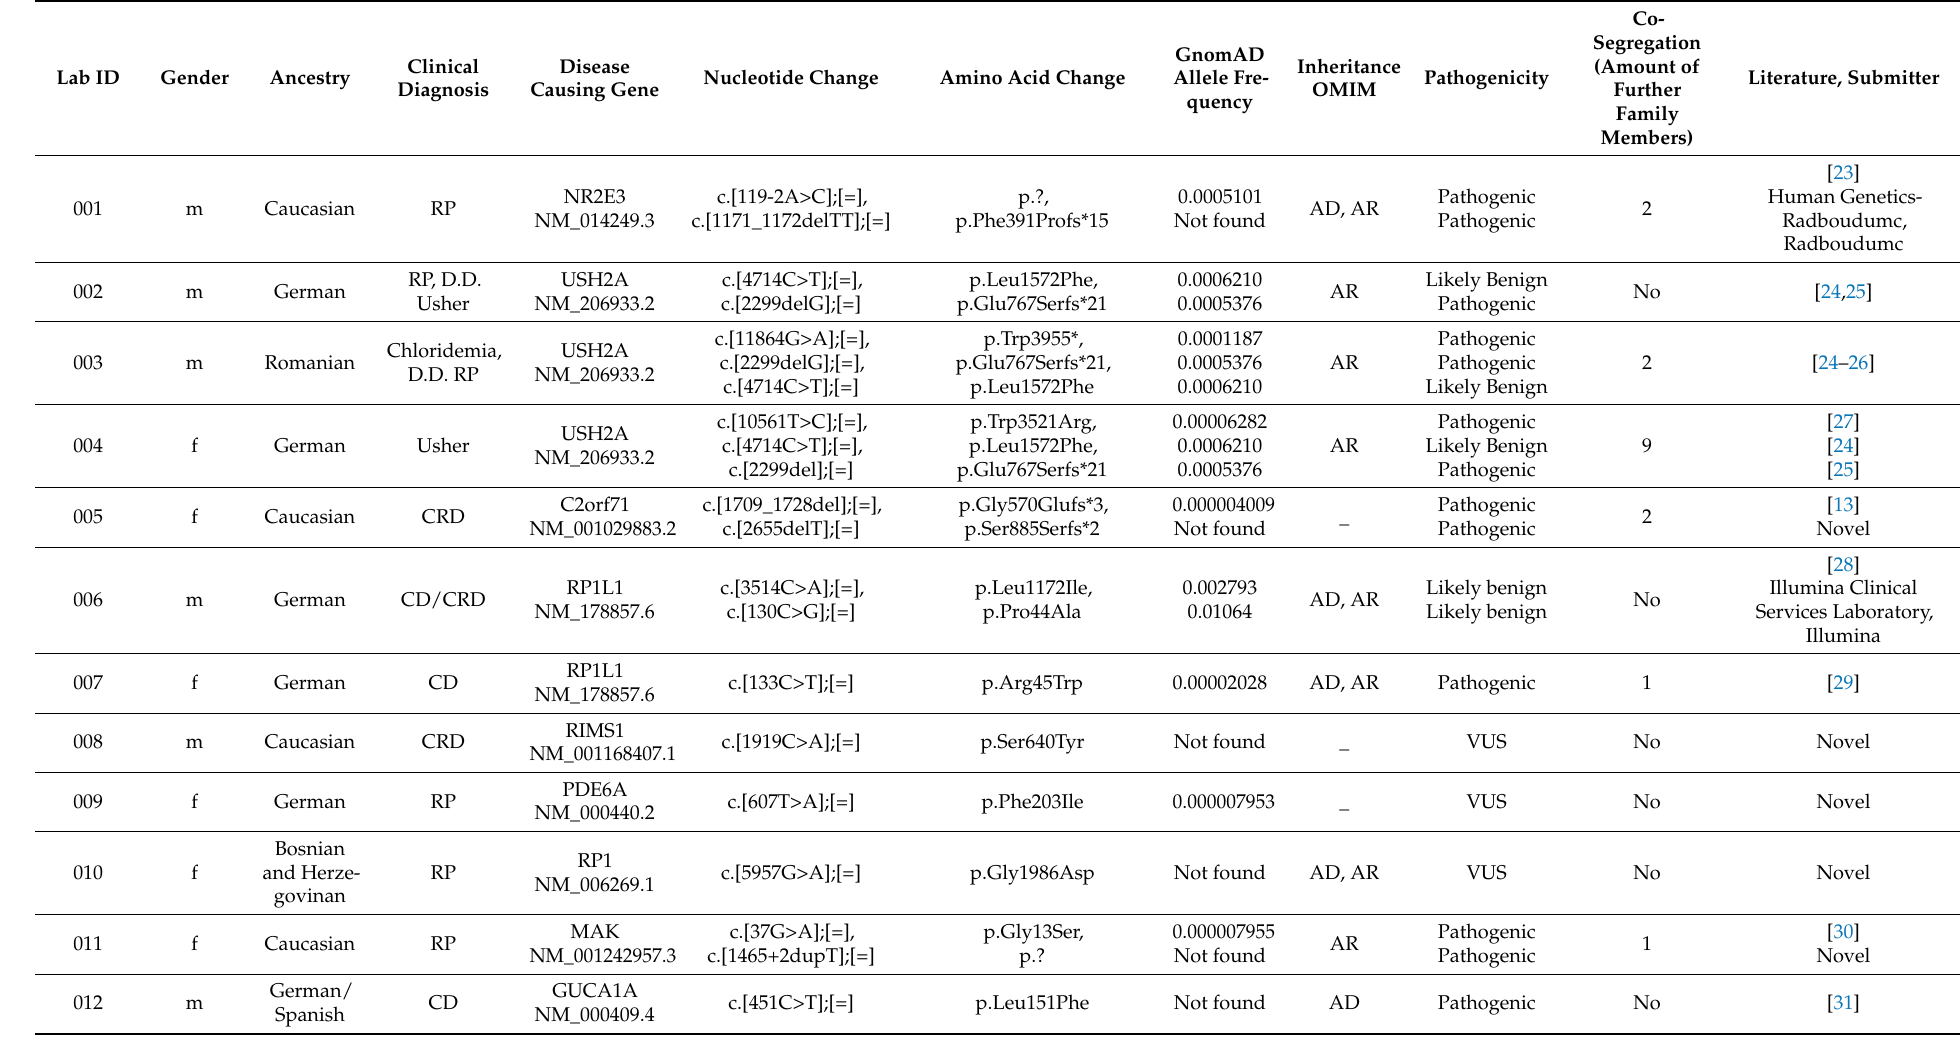
Table 1. RD-associated variants detected in this